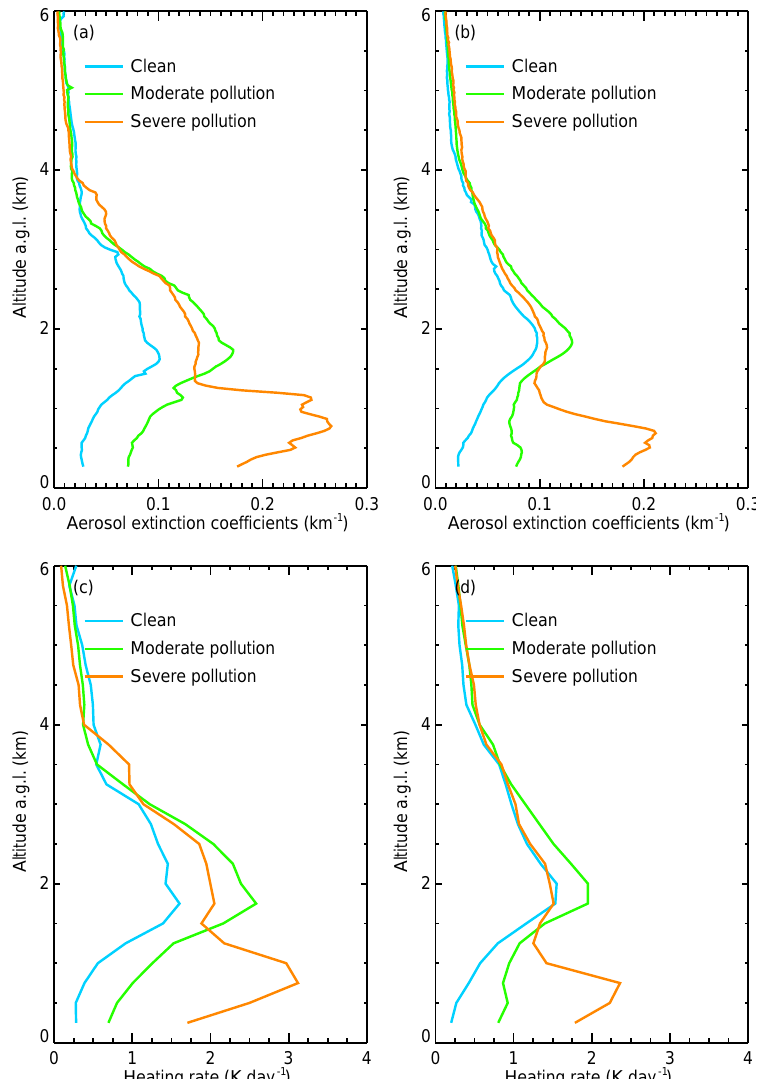
Figure 5. Mean summertime aerosol extinction profiles measured by the MPL in (a) 2013 and (b) 2014 and summertime atmospheric heating rates induced by aerosols in (c) 2013 and (d) 2014. Profiles representing relatively clean, moderate pollution, and severe pollution scenarios are shown as blue, green, and yellow lines, respectively. The “a.g.l.” in the ordinate labels stands for “above ground